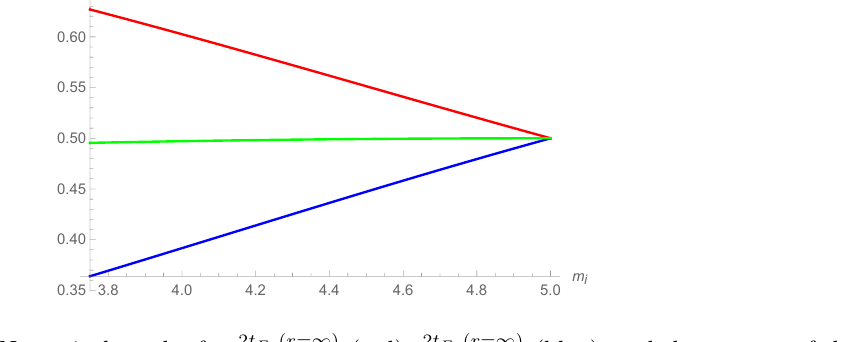
Figure 15 . D = 3 Numerical results for 2 t Ee ( r = 1 ) (red), 2 t Ee ( r = 1 ) (blue), and the average of the (cid:12) e (cid:12) e two (green) with (cid:21) = (cid:0) 1 and (cid:20) = 1 = 2 as a function of m i = (cid:22) i (cid:0) 1 for m e = (cid:22) e (cid:0) 1 = 5. In fact, the ratio depends only on m e = (cid:22) e (cid:0) 1 for m e < 1. Results for other values of (cid:20) are similar. For (cid:21) = (cid:0) 1 m i (cid:22) i (cid:0) 1 m i the system is symmetric under exchanging the labels e and i , so for m e > 1 one can instead (cid:12)nd m i 2 t Ee ( r = 1 ) from the blue curve and 2 t Ei ( r = 1 ) from the red curve. All ratios are 1 and m e = 1, but (cid:12) e (cid:12) i 2 m i the average (green) is smaller at other